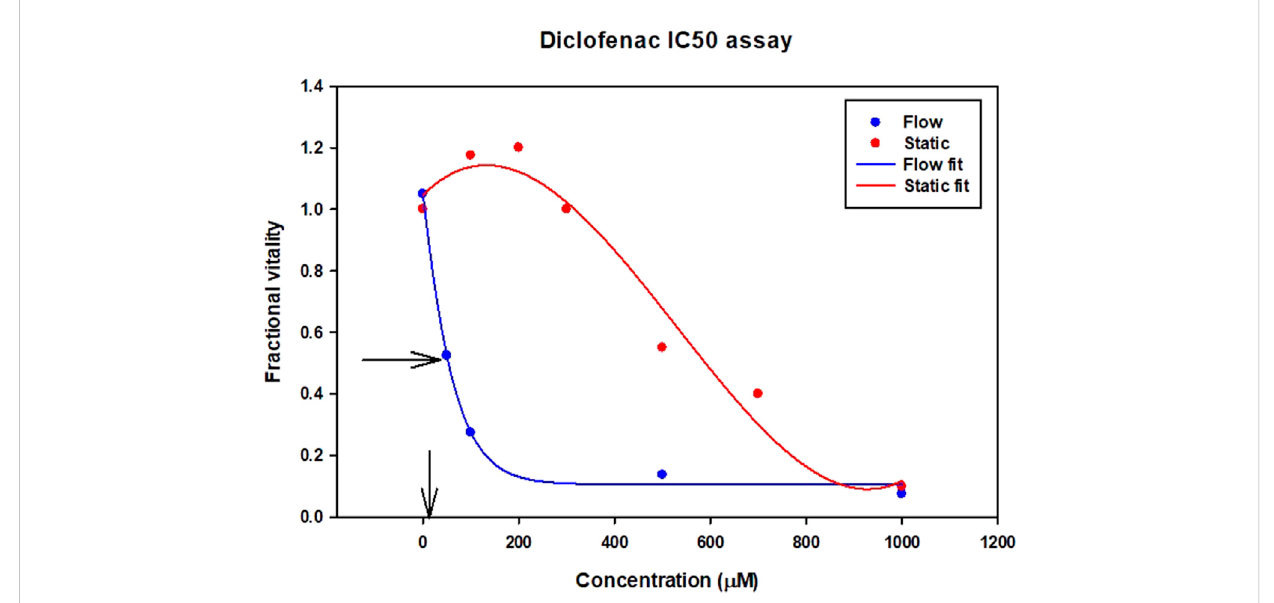
FIGURE 3 Diclofenac Drug Toxicity illustrated by IC50 results for different assays. Vertical arrow on x axis indicates clinical IC50 value from clinical trials.